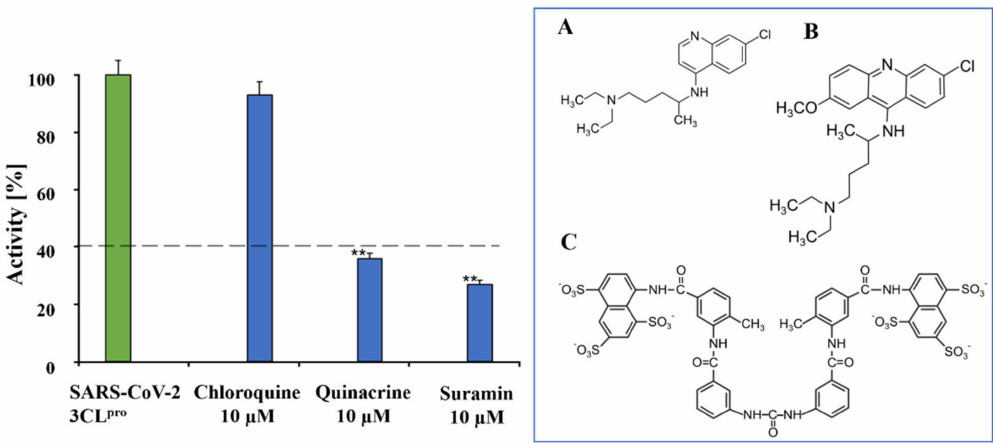
Figure 1. Preliminary inhibition tests of chloroquine, quinacrine, and suramin against SARS-CoV-2 3CL pro . Quinacrine and suramin inhibited the virus protease activity by more than 60%. On the contrary, chloroquine showed no relevant inhibition, just about 10%. The blue box shows the molecular structures of chloroquine ( A ), quinacrine ( B ), and suramin ( C ). Data shown are mean ± SD from 3 independent measurements ( n = 3). Asterisks mean that the data differ from the control (0 µ M inhibitor) significantly at p < 0.01 (**) according to ANOVA and Tukey’s